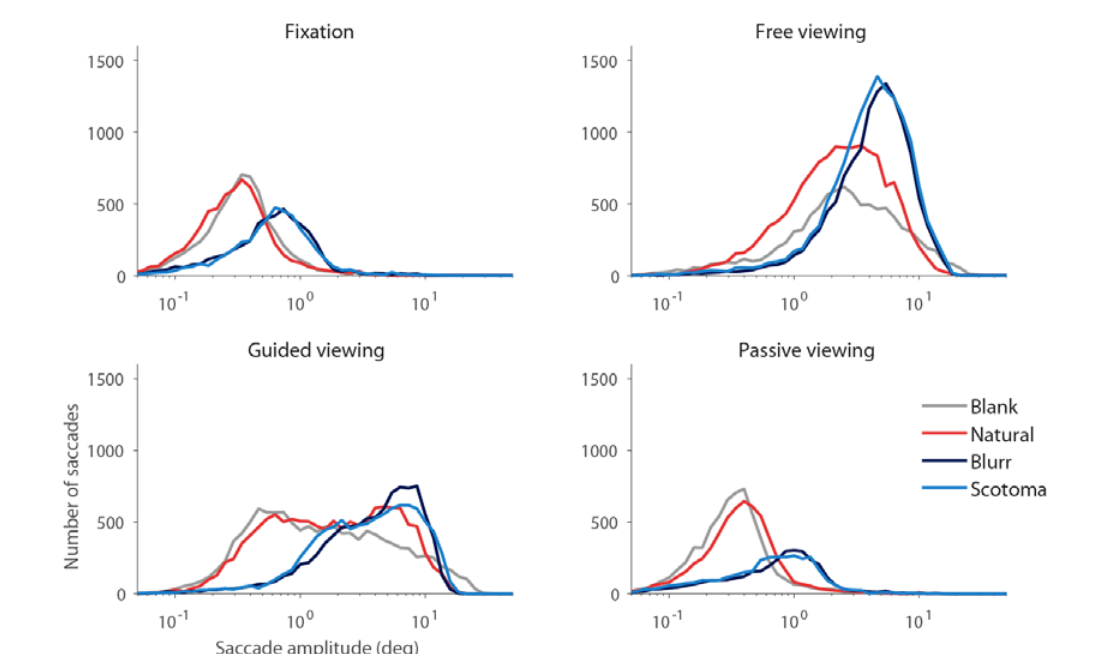
Figure 3. Saccadic amplitude distribution in each experimental condition. Distributions arranged by viewing task condition (N=6